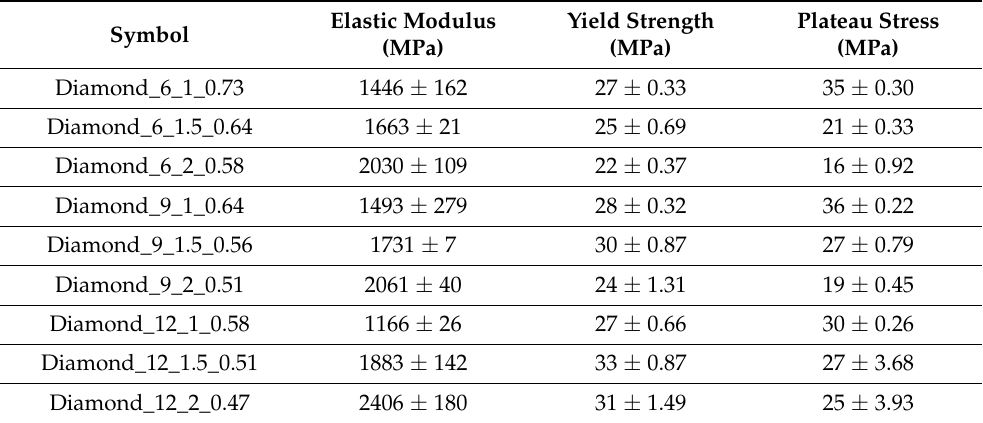
Table 4. Compressive mechanical properties of tested Diamond TPMS cylindrical structures (mean and standard deviation).